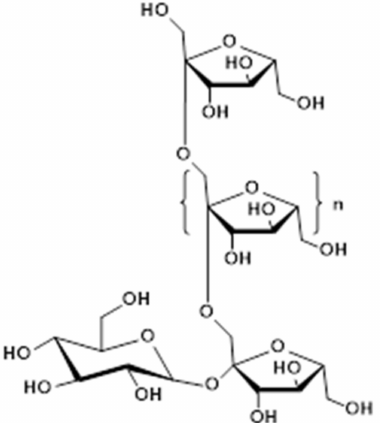
Figure 1. Inulin